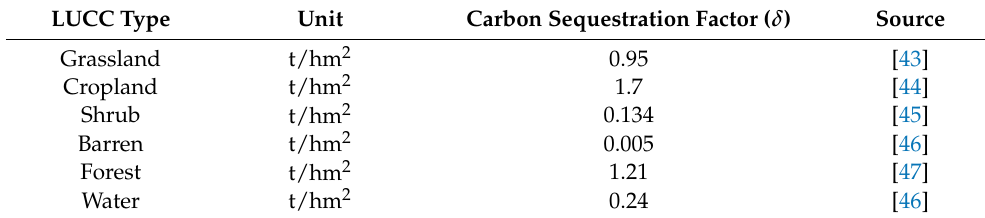
Table 1. The carbon sequestration coefficients based on the LUCC type